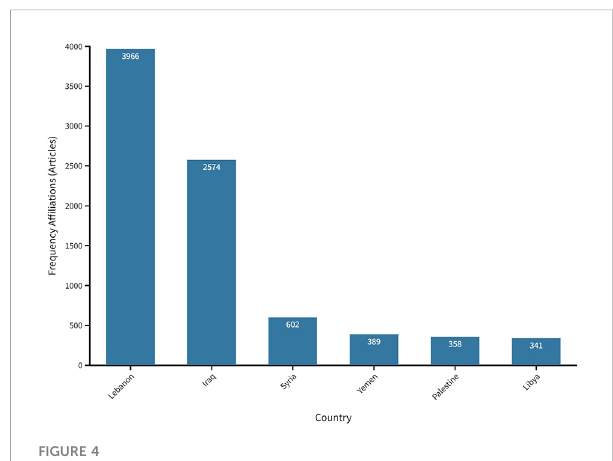
FIGURE 4 Country production from 2000 to